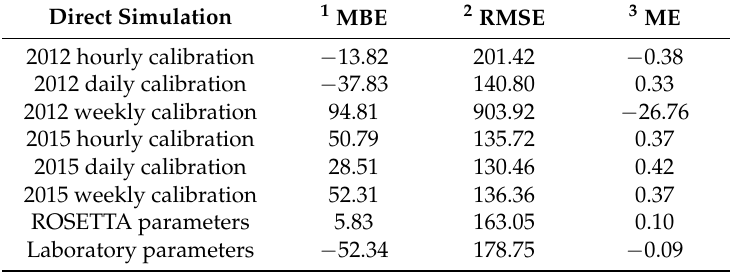
Table 5. Statistical measures for direct simulations over the period from 2012 to 2016 using eight different sets of parameters (see Figure 3). All the sets of parameters were obtained through calibration except for the ROSETTA parameters set and laboratory parameters set. The statistical measures are related to the entire profile, and those referring to each layer are provided as supplementary material. Direct Simulation 1